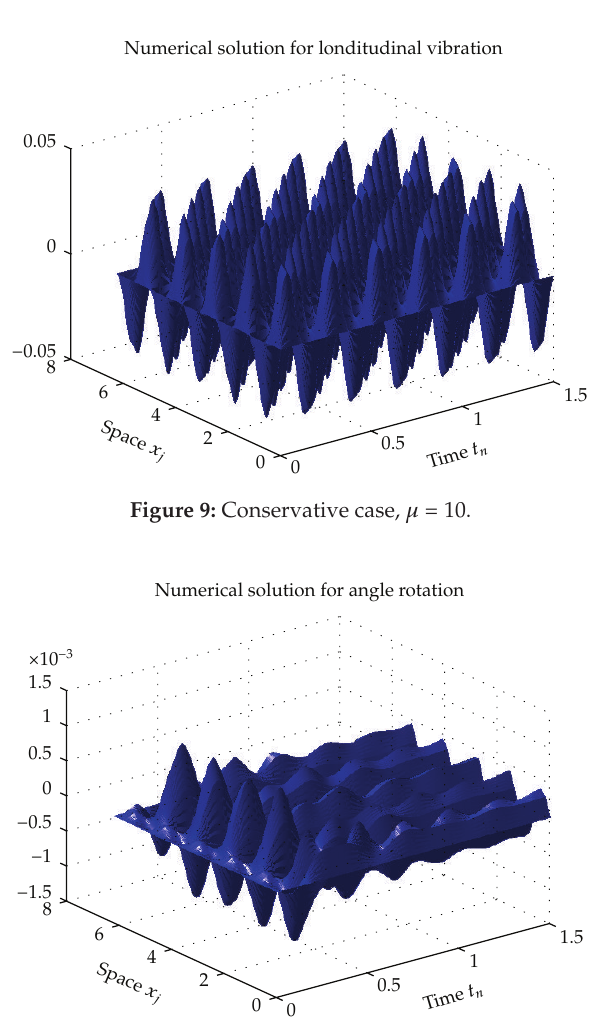
Figure 10: Total dissipation case, μ (cid:8)